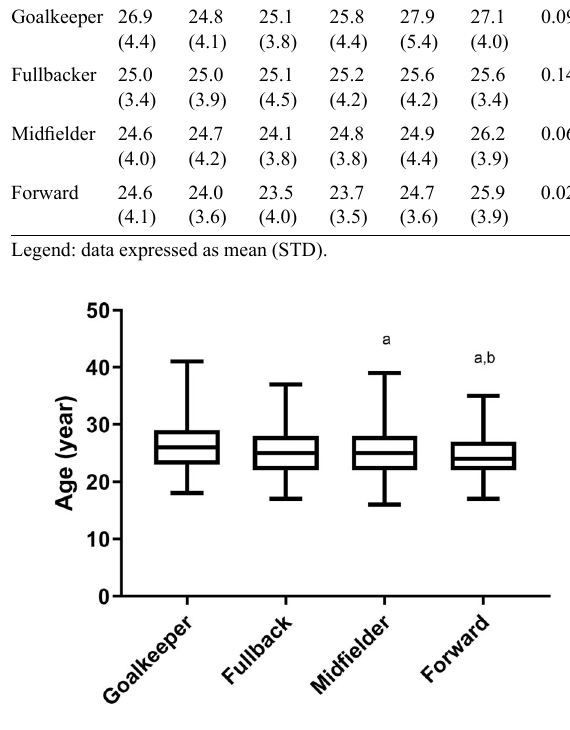
Figure 3 - Age of peak performance in women's football according to playing positions. Legend: a - statistically different from the goalkeeper, b - statistically different from fullback in Kruskal Wallis test (p <